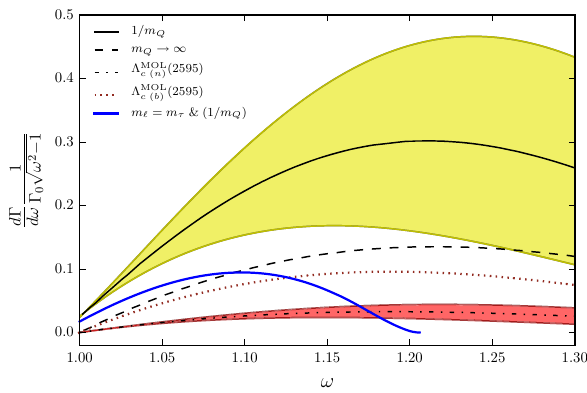
Fig. 2 Differential (cid:2) b → (cid:2) ∗ c ( 1 / 2 − )τ ¯ ν τ (solid blue line) and (cid:2) b → (cid:2) ∗ ( 1 / 2 − ) e ¯ ν e rates calculated using different approaches. The black c dashed and solid lines, together with the error bands of the latter, are taken from Fig.1a of Ref. [14], where the final baryon is treated as the J P = 1 / 2 − member of the lowest-lying j P q = 1 − HQSS dou- blet. The dashed line shows the m Q → ∞ prediction, Eqs. (22) and (23), while the solid line include 1 / m Q effects for σ 1 (ω) = 0. The bands account for the changes in the differential decay rate when σ ( 1 ) is varied in the range [− 1 . 2 , 1 . 2 ] GeV. The spectrum of the 1 τ − mode, which ends around ω ∼ 1 . 2, is calculated using Eq. (26) with (cid:22) 1 , 2 given in Eq. (29), and taking σ 1 (ω) = 0. (Further details on the O ( 1 / m c ) corrections for τ − decays can be found in Table 4). On the other hand, the lowest dotted and dashed-dotted curves, together with the error bands of the latter, stand for the decay into ( 2595 ) ] and narrow [ (cid:2) MOL ( 2595 ) ] molecular reso- the broad [ (cid:2) MOL c ( b ) c ( n ) nances found in the SU ( 6 ) lsf × SU ( 2 ) HQSS model of Refs. [66,67]. These differential rates have been obtained multiplying the correspond- ing molecular gG ratios given in Table 2 by the O ( 1 / m Q ) improved (cid:2) → (cid:2) ∗ ( 3 / 2 − [ j P = 1 − ] ) e ¯ ν b e distribution displayed in Fig.1b of c q Ref. [14]. Central values have been evaluated using the black solid line of this latter figure. The bands, depicted for the decay into the narrow (cid:2) ( 2595 ) molecularstate,showtheimpactinthespectrumoftheuncer- c tainties on the O ( 1 / m Q ) corrections, and have been calculated using the shaded region shown in Fig.1b of Ref.